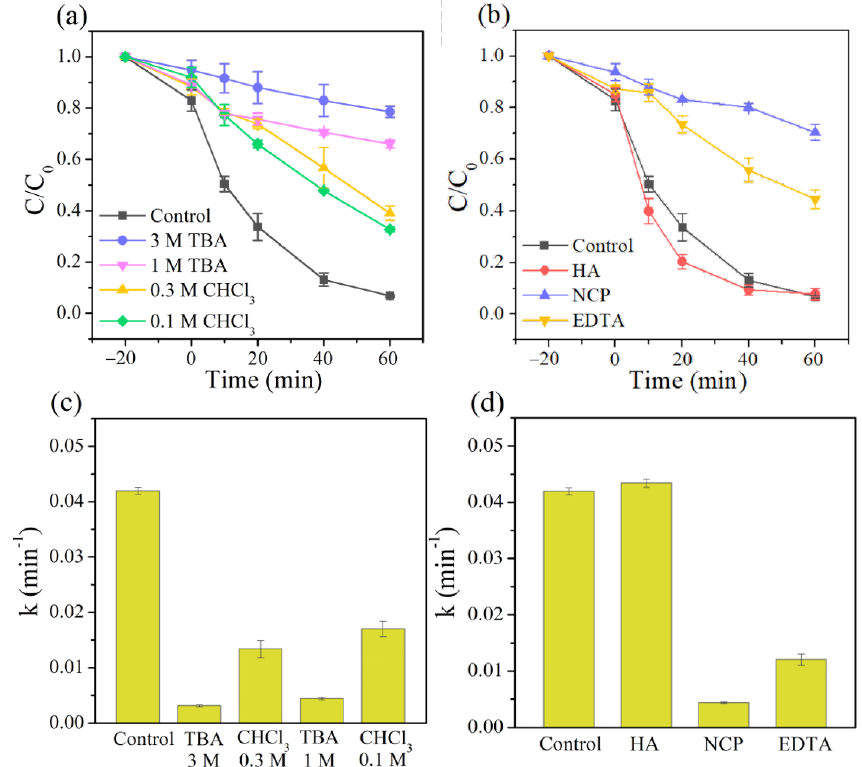
Figure 4. Effects of ( a ) different scavengers (TBA and CHCl 3 ), ( b ) HA, NCP, and EDTA for TC removal in the 3DHP-ZVC/H 2 O 2 system, and ( c , d ) their corresponding reaction rate constant under different